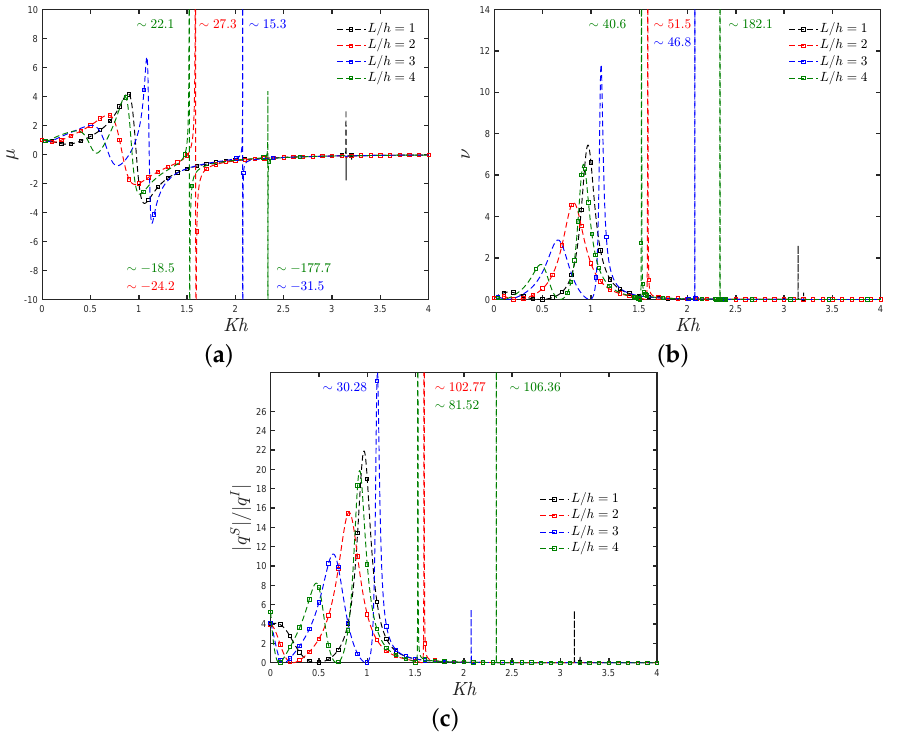
Figure 14. The influence of the length of the gap between the rear and reflecting walls L / h on the ( a ) radiation susceptance coefficient, ( b ) radiation conductance coefficient and ( c ) non-dimensional induced volume flux due to the scattering potential against Kh with a 1 / h = a 2 / h = 1/8, b / h = 1 and w 1 / h = w 2 / h =